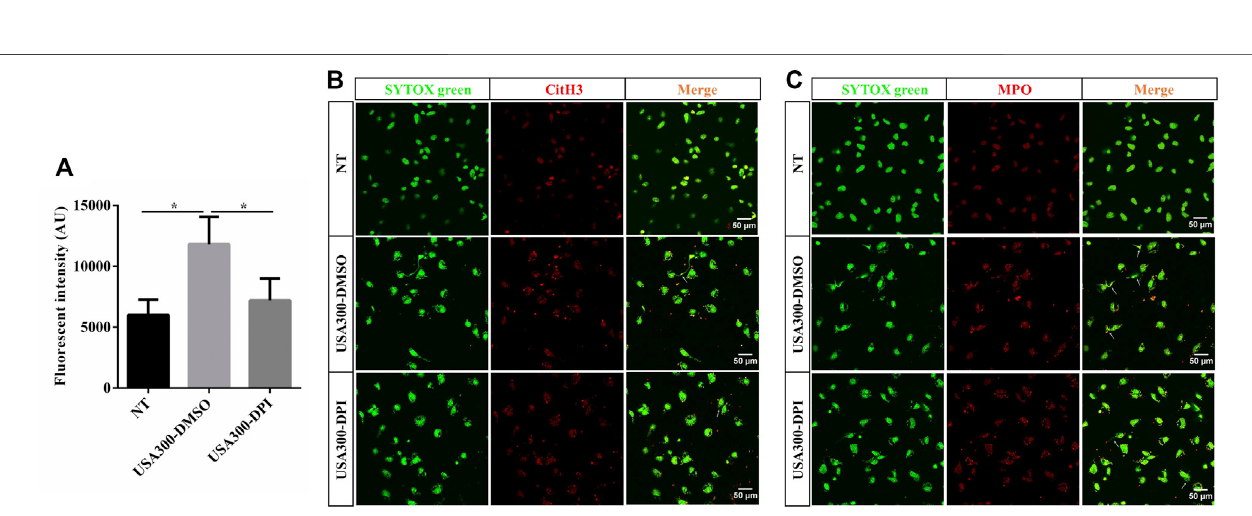
FIGURE3| NADPHoxidase-derivedROSfacilitatesthe S.aureus -induced ETsformation.WTBMDMswerepretreatedwithDPI(10 μ M)and theninfected with S. aureus (MOI: 20) for 3 h. (A) The cfDNA in supernatants was stained with SYTOX Green and analyzed on a fl uorescent reader. DNA decorated with CitH3 (B) and MPO (C) within ETs were detected using a scanning confocal microscope. DNA was stained with SYTOX green. METs structures were marked with white arrows. Data were pooled from 3 independent experiments. Data were analyzed using one-way ANOVA with Dunnett ’ s multiple comparison test, * p < 0.05.